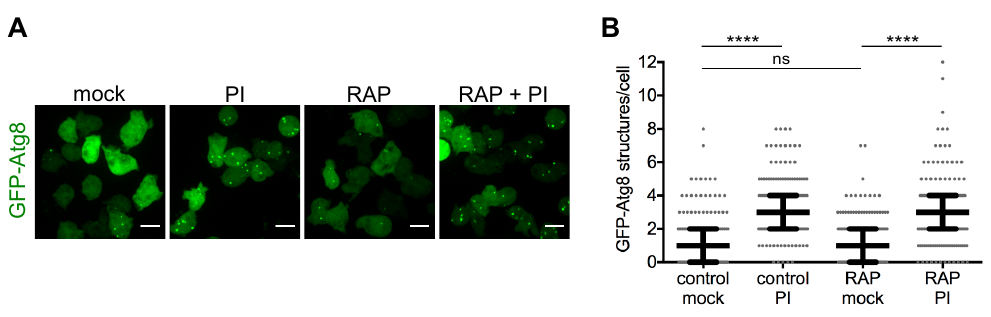
Figure 2. A short-term rapamycin (RAP) treatment does not induce autophagic flux in Dictyostelium . Dictyostelium Ax2(Ka) cells expressing green fluorescent protein (GFP)-Atg8 were treated or mock-treated with RAP at 500 nM for 2 h. One hour before the end of the treatment, cells were incubated or not with a protease inhibitor cocktail (PI, Roche 11873580001) at 2.5×. ( A ) Representative maximum projections of live cells under the treatments described above. Scale bars, 10 µm; ( B ) Median and interquartile ranges of the number of GFP-Atg8 structures per cell during the mentioned treatments. Each dot represents one cell; 162–168 cells per condition were counted. The values of λ that define the Poisson distribution of each data set and differences between them were calculated as described before [34] (**** p ≤ 0.0001; ns, p > 0.05). No significant differences were observed by quantification of the percentage of cells with GFP-Atg8 dots under RAP treatment (not shown).